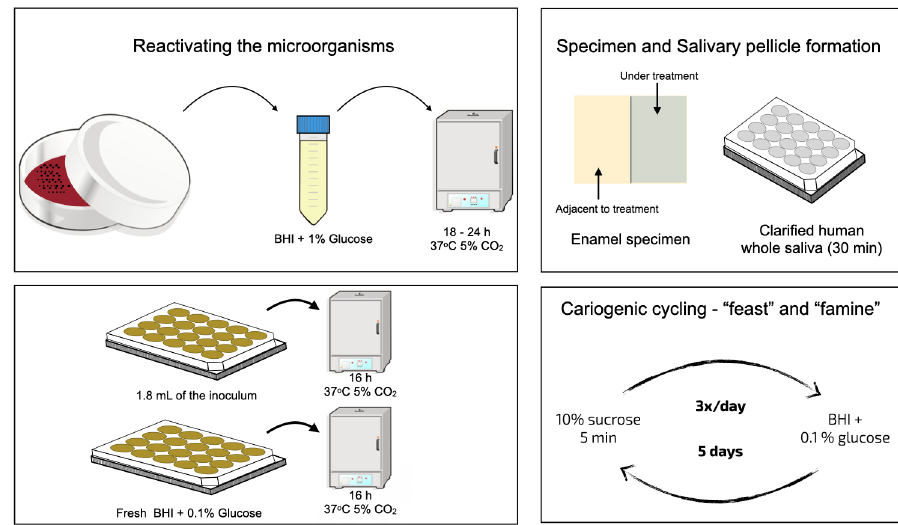
Figure 2- A flowgram of